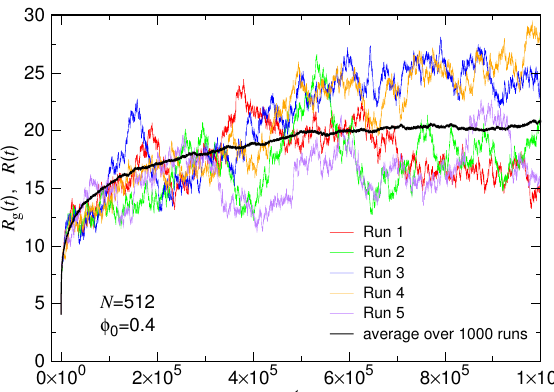
Figure 2. Variations of chain size R g ( t ) in five single runs for the case ( N , φ 0 ) = ( 512,0.4 ) , denoted by Run 1 to Run 5 in the legend. The averaged variation R ( t ) over 1000 independent runs is plotted in black color for comparison.